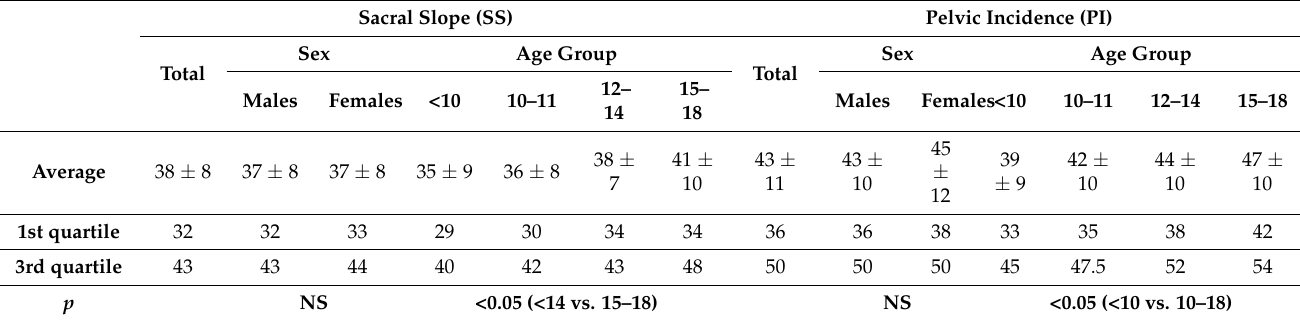
Table 3. Sacral slope (SS) and pelvic incidence (PI) variations with